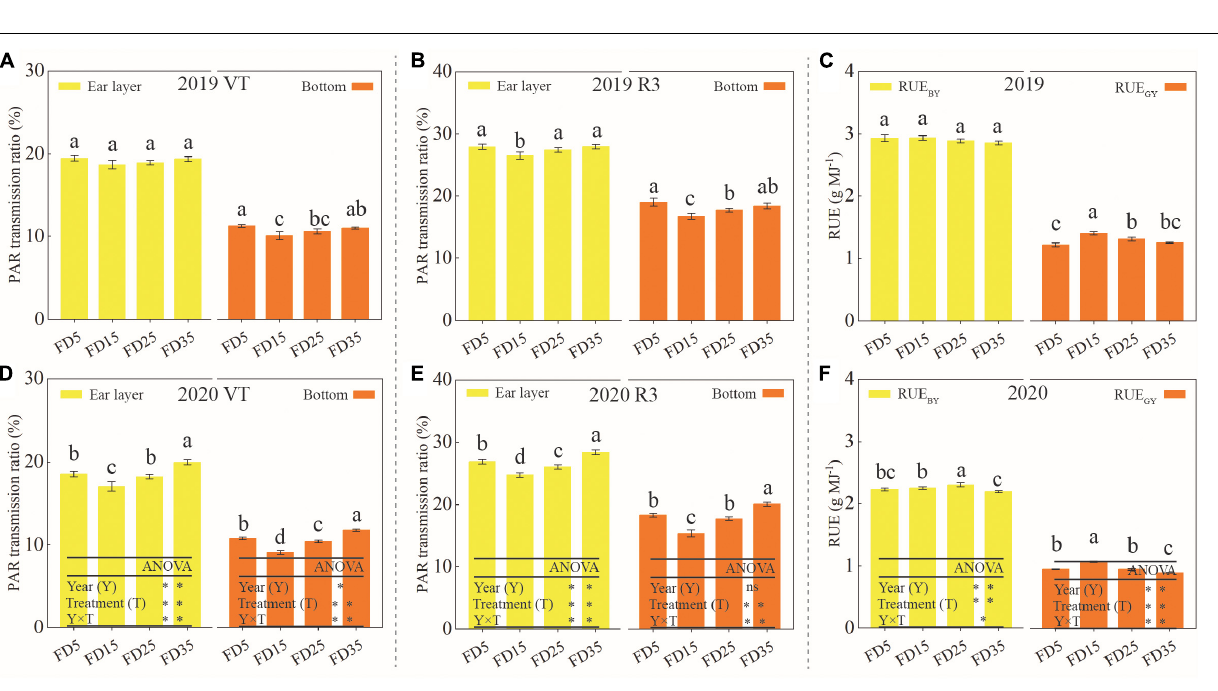
FIGURE 8 | Effects of fertilizer application depths on photosynthetically active radiation (PAR) transmission ratio at VT (A,D) and R3 (B,E) stages of summer maize in 2019 and 2020. Effects of fertilizer application depths on radiation use efficiency (RUE) of summer maize in 2019 (C) and 2020 (F) . FD5, fertilizer application at a depth of 5 cm; FD15, fertilizer application at a depth of 15 cm; FD25, fertilizer application at a depth of 25 cm; FD35, fertilizer application at a depth of 35 cm; RUE GY , radiation use efficiency based on grain yield; and RUE BY , radiation use efficiency based on biomass yield. The vertical bars stand for standard deviation. The different lowercase letters indicate a significant difference among the treatments at P < 0.05 using the LSD method. ns, no significant difference; ∗ , significant at P < 0.05; ∗∗ , significant at P <